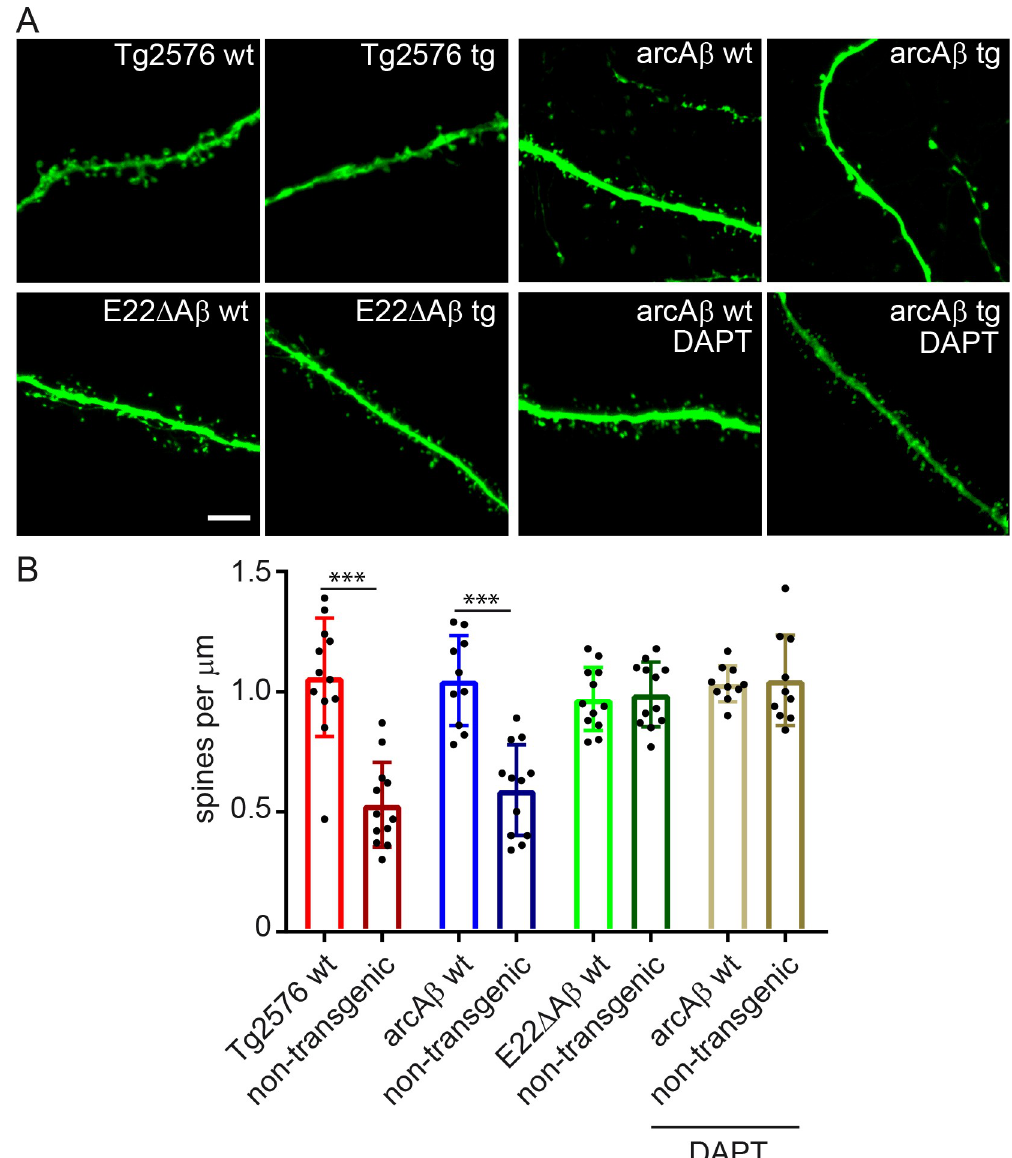
Fig 1. Reduction in dendritic spine density in hippocampal slices from Tg2576 and arcA β - but not E22 Δ A β transgenic mice. A: Representative confocal images of dendritic segments of hippocampal slices from Tg2576, arcA β - and E22 Δ A β transgenic mice and the respective non-transgenic littermates. B: Spine counts per μ m dendrite. Spine density was reduced in cultures from Tg2576 tg mice and arcA β tg mice but not in E22 Δ A β tg mice. Treatment with 0.5 μ M DAPT abolished spine reduction in arcA β tg slices. n = 10–12; Data are means ± SD. Statistical significance was assessed by one-way ANOVA with Tukey’s multiple comparison test ( ��� p < 0.001). Scale bar: 5 μ m. Sindbis virus, allowing high-resolution imaging of dendritic segments and spines [19]. As shown previously [13], spine density was strongly reduced in slices from arcA β mice compared to slices from non-transgenic (non-tg) littermates (Fig 1A and 1B). This was rescued by treat- ment with the γ -secretase inhibitor DAPT at 0.5 μ M indicating that spine reduction is medi- ated by A β and showing the validity of the transgenic slice culture model. Slices from Tg2576 mice displayed a similar reduction in spine numbers compared to arcA β tg mice whereas